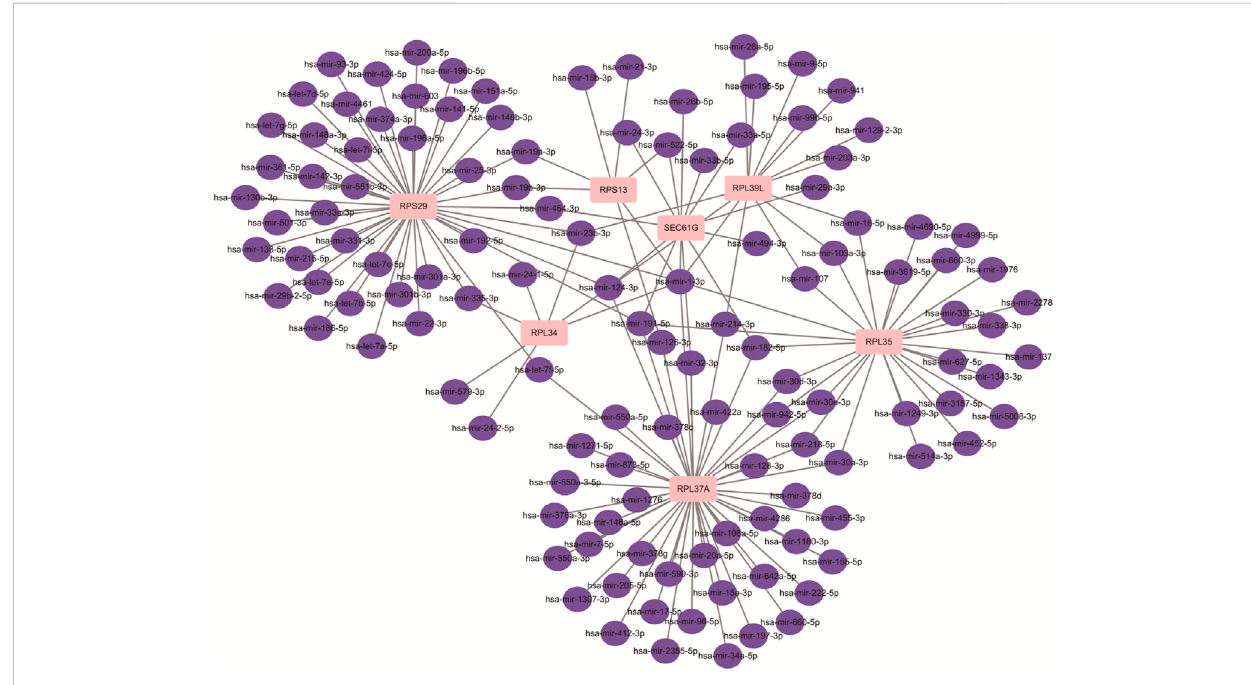
FIGURE 6 The network of mRNA-miRNA.